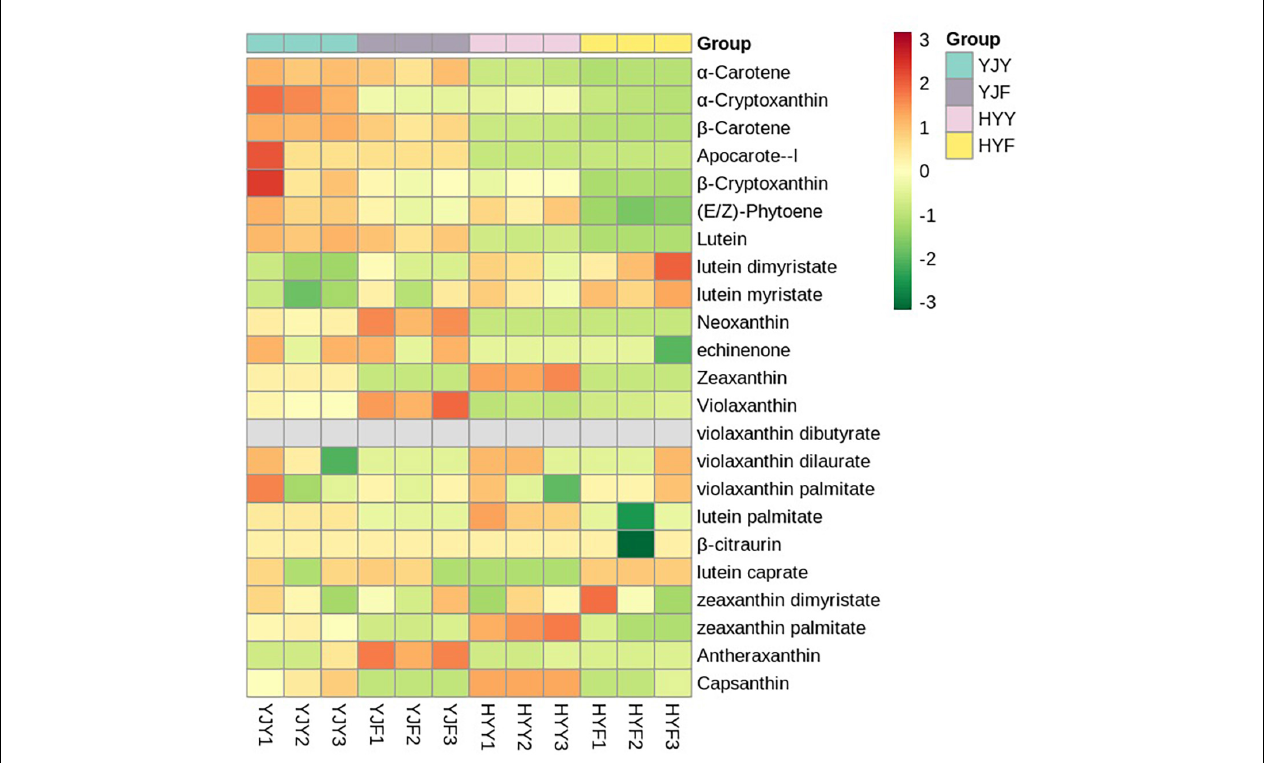
FIGURE 4 | Heat map of volatile compounds clusters in “Yinghong 9” and “Huangyu” fresh and their fermented leaves. Red and green indicate higher and lower abundances, respectively. YJY was “Yinghong 9” fresh leaves, YJF was “Yinghong 9” fermented leaves; HYY was “Huangyu” fresh leaves, HYF was “Huangyu” fermented